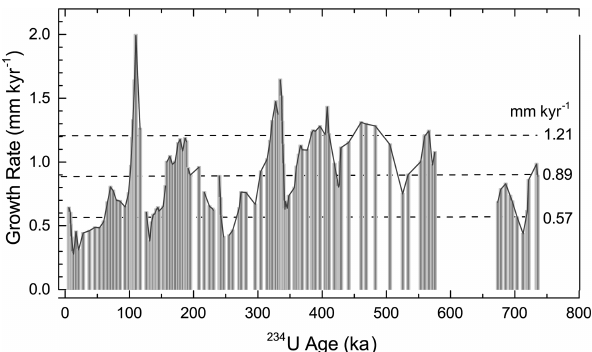
Figure 6. Growth rate of DH2 mammillary calcite based on the OxCal age model (Fig. 5). The dashed lines indicate the average value and 1 standard deviation above and below the average.